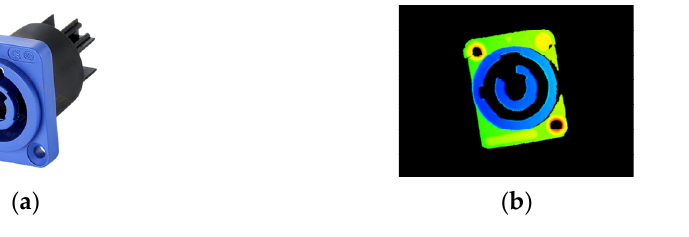
Figure 17. The image and depth image of the Neutrik plug: ( a ) the image of the Neutrik plug; ( b ) the depth image of the Neutrik plug.